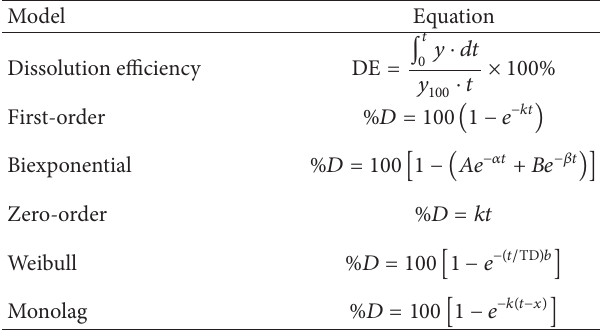
Table 3: Loading efficiency values obtained to MAN-loaded PCL and PHBV